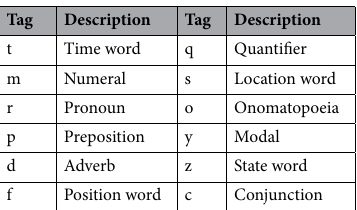
Table 1. Part-of-speech tag table of special words. Part-of-speech tagging uses the Language Technology Platform (LTP) part-of-speech tag